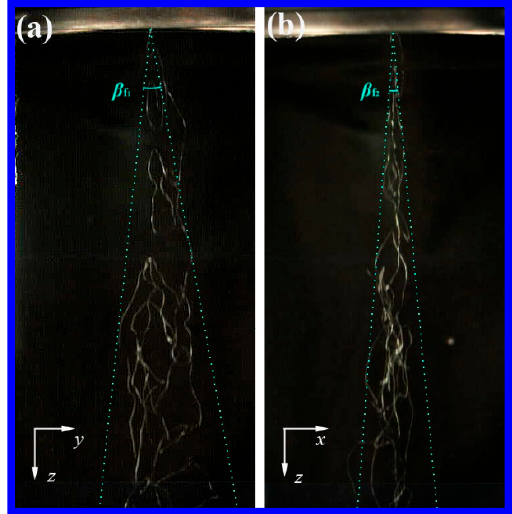
Figure 11. The fiber paths below the melt-blown slot die. ( a ) The fiber path in the y–z plane. ( b ) The fiber path in the x–z plane. The corresponding size of each image is 62.5 mm × 130 mm.